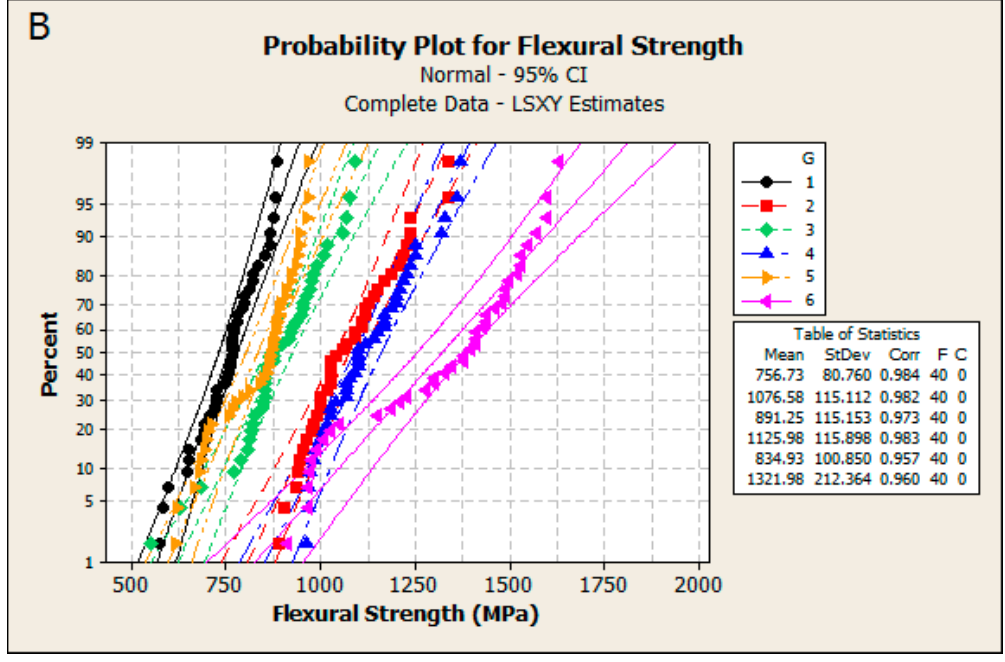
Figure 3. Probability plots for biaxial flexural strength in each tested group G for Weibull LS ( A ) and Normal LS ( B ).